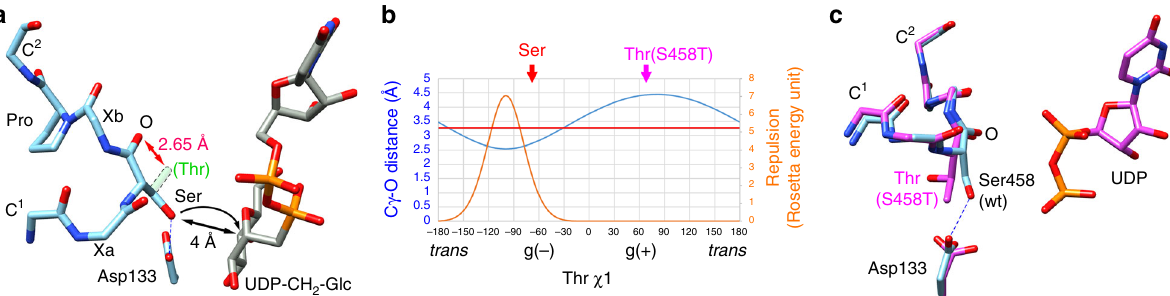
Fig. 5 The structural basis for the serine-speci fi city of POGLUT1/Rumi. a Superimposition of hEGF12 and UDP-CH 2 -glucose. The hypothetical position of the γ -methyl group of a Thr residue in the gauche ( − ) rotamer is indicated by dotted lines . The minimum distance for either a Ser or a Thr to the UDP-CH 2 - glucose is 4 Å. b Rotamer analysis of Thr at the O -glucosylation site. The distances between the γ -methyl group and the backbone carbonyl group are plotted against the χ 1 angles as the blue curve . The minimum non-clashing van der Waals distance between a methyl carbon and a carbonyl oxygen atom (3.25 Å) is indicated by the red line . The repulsive energy is plotted as the orange curve in Rosetta energy units. The red “ Ser ” indicates the χ 1 angles found in the wild-type EGF-like domain complexes. The magenta “ Thr ” indicates the χ 1 angle found in the hEGF12(S458T) mutant complex. c The crystal structure of the O -glucosylation site mutant (S458T; magenta ) of hEGF12 superimposed on the wild type structure ( blue ). The minimum distance between the co- crystallized UDP and Thr458 is > 6 Å